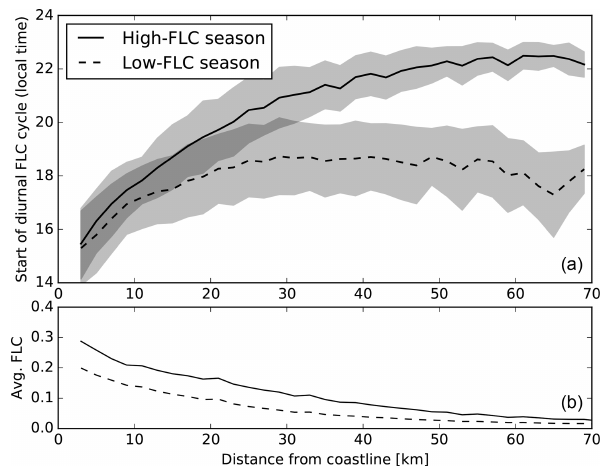
Figure 5. (a) Start of diurnal FLC cycle in the central Namib as a function of distance from the coastline. Two different seasons are shown: high-FLC season (September, October and November) and low-FLC season (April, May and June). Shaded area illustrates mean ± 1 standard deviation. (b) Average relative FLC occurrence frequency in the two seasons. The same pixels are considered as in panel (a) and averaged in 2km distance bins ( x axis).